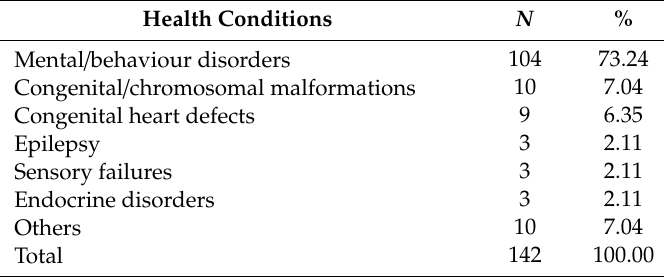
Table 1. The distribution of medical disabilities.